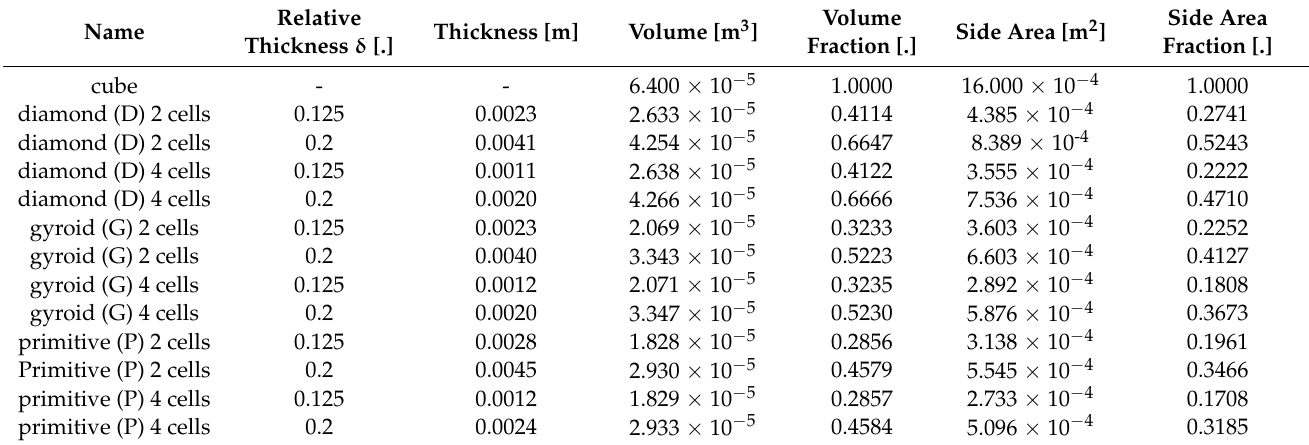
Table 1. Parameters used for generating different periodic surface structures, together with their impact on volume and the side area of a specific structure.